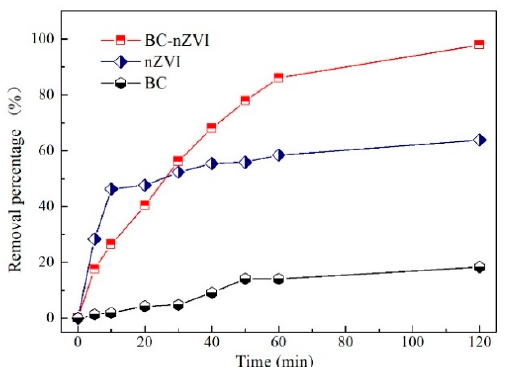
Figure 4. Comparative degradation of MO using different materials. The dosage of BC, nZVI, and BC-nZVI were 3 g/L, 0.5 g/L, and 0.5 g/L (the dry weight of nZVI in BC-nZVI used) with an initial MO concentration of 200 mg/L, temperature of 25 °C, and original pH.